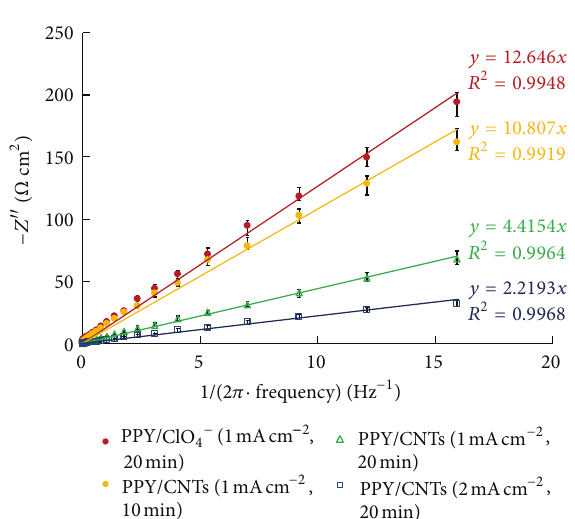
Figure 5: Capacitance evaluation for PPY / ClO 4− pure polymeric films and PPY/CNTs composites obtained at different charge densi-